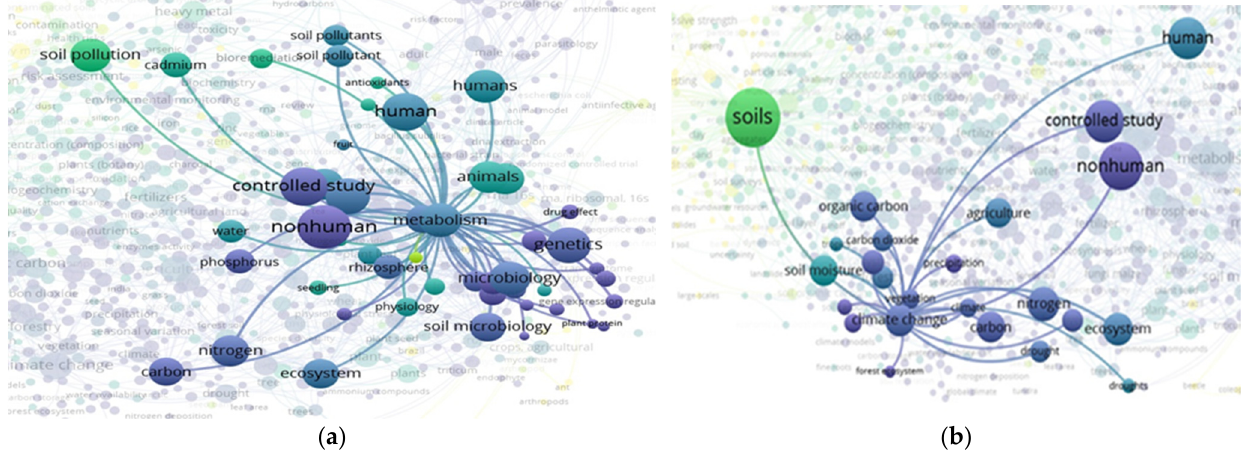
Figure 4. Analyzing Scopus with the VOSviewer. The metabolism and climate change paradigm. ( a ) Metabolism is associated with: Animals; Soil pollution; Water; Cadmium and Bioremediation (green circles); Microbiology; Soil microbiology; Nitrogen; Carbon; Ecosystem; Genetics and Human(s) (purple circles). ( b ) Climate change is associated with: Carbon; Nitrogen; Organic carbon; Carbon dioxide; Precipitation and Drought (purple circles) and Soils; Soil Moisture; Agriculture; Ecosystem and Droughts (purple circles); Microbial community; Metabolism; Bacteria; Nitrogen Carbon; Climate change; Human (purple circles) and Soil pollution, Cadmium, Heavy metal, and Bioremediation (green circles).